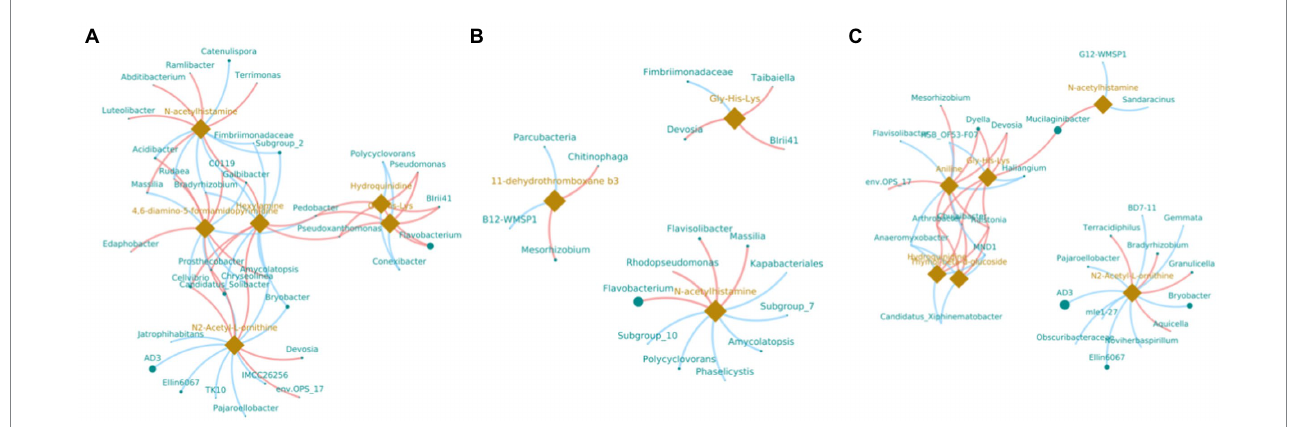
FIGURE 9 Connection network between DEMs and related bacteria in different treatment groups. (A) MF-HZ23 vs. the control; (B) MF-HZ23 plus CCF vs. the control; and (C) CCF vs. the control. Green dots and orange prisms represent bacteria and metabolites, and the size of nodes and prisms represents the relative abundance of bacteria and metabolites, respectively. Red lines and blue lines represent positive correlation and negative correlation,